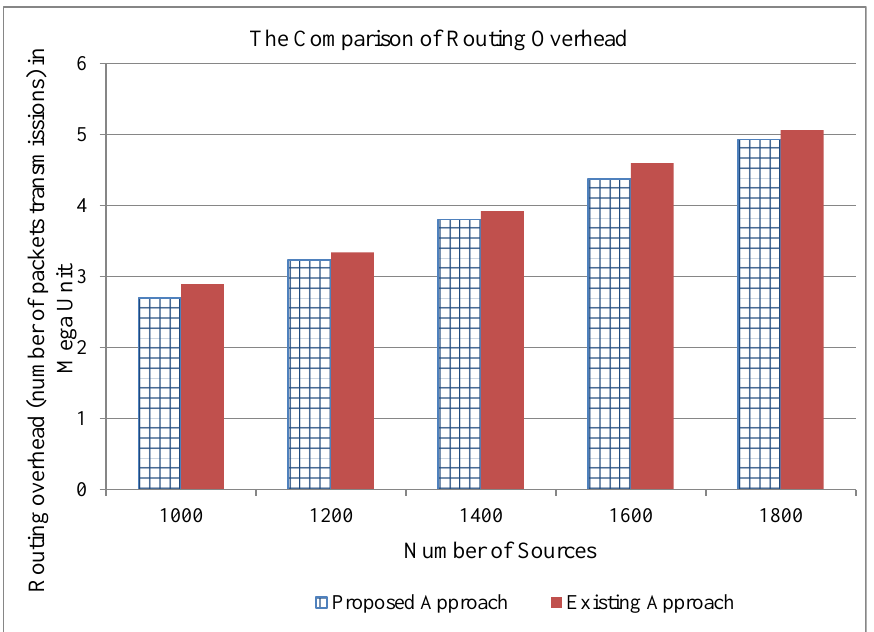
Figure 6. The comparison of traffic overhead of the existing and proposed approaches for three cache